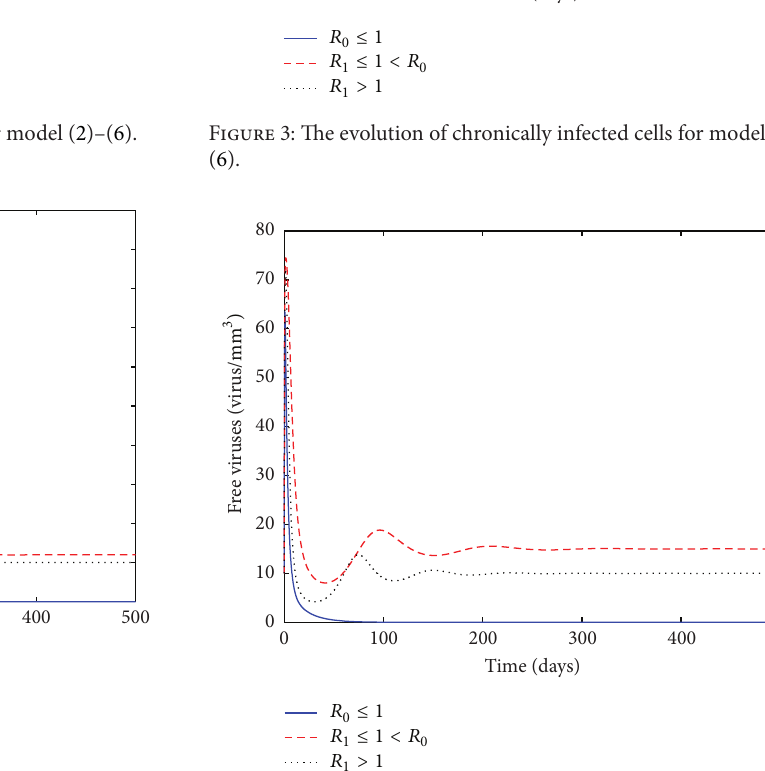
Figure 2: The evolution of short-lived infected cells for model (2)– (6).